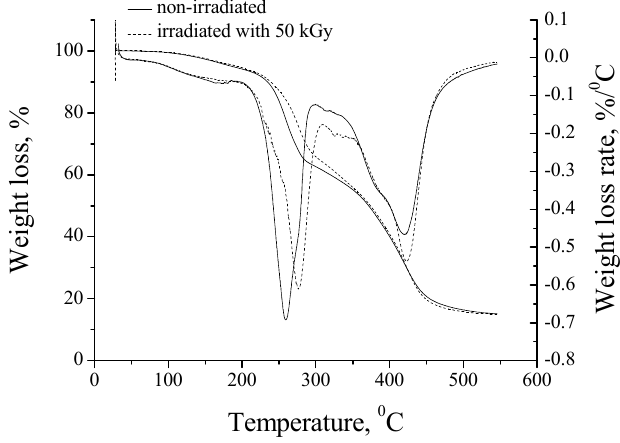
Figure 7. TG curves for PAA before and after irradiation.